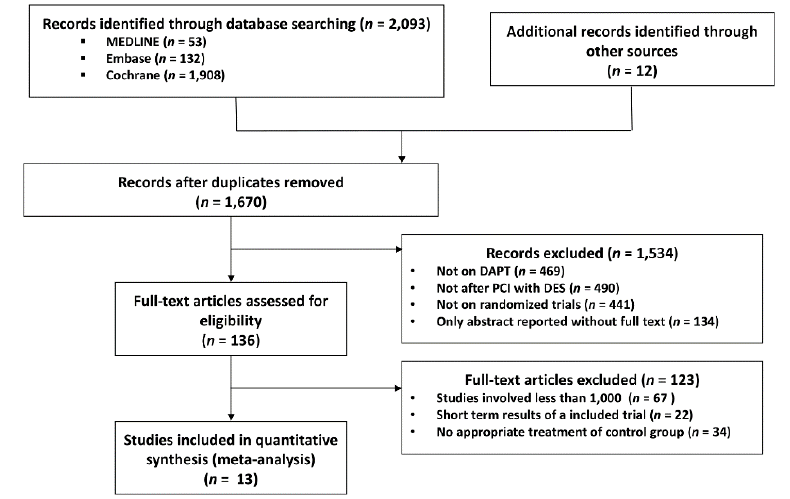
Figure 1. Meta-analysis flow diagram. DAPT, dual anti platelet therapy; PCI, percutaneous coronary intervention; DES, drug eluting